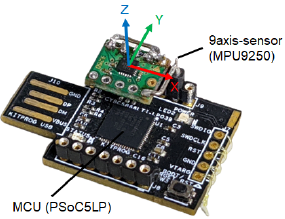
Figure 10. Experimental device for retrieving 9-axis sensor data.